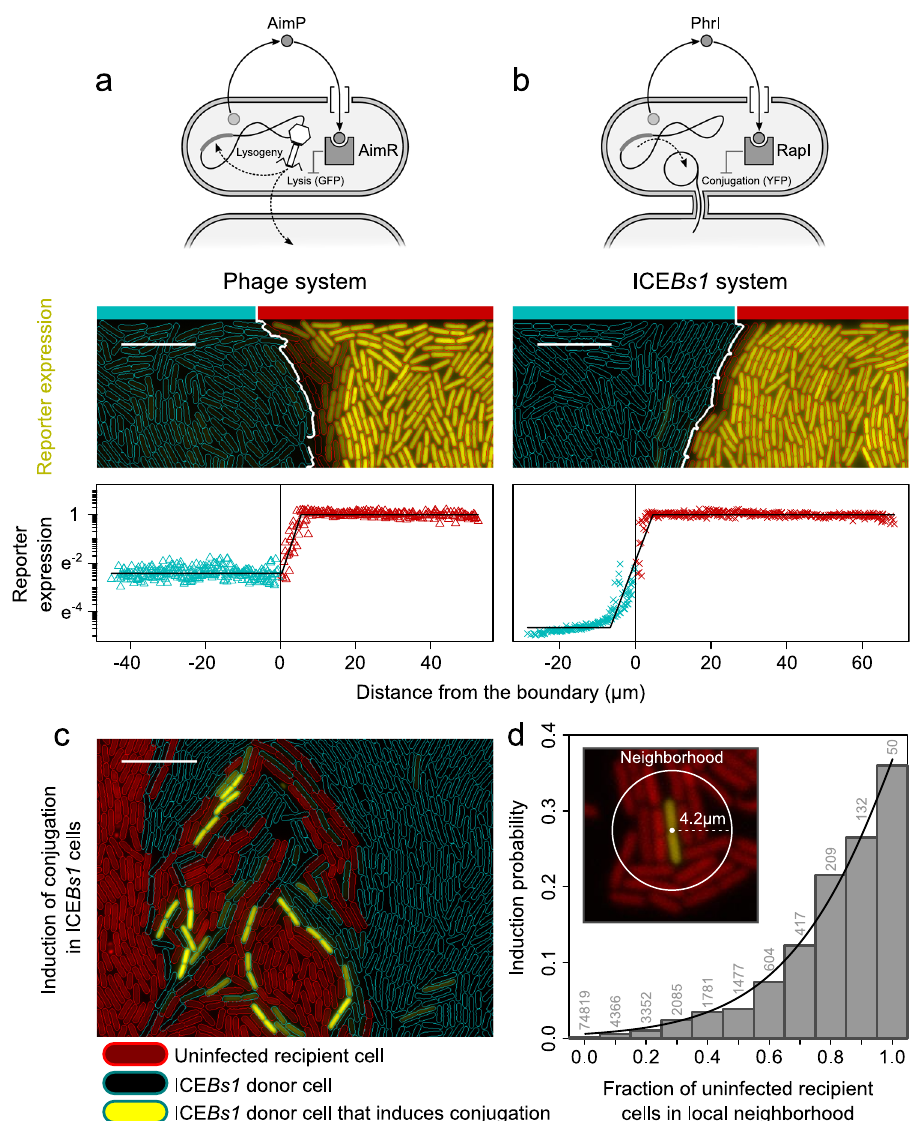
Fig. 4 Short-range communication regulates horizontal gene transfer. Quorum-sensing systems of a phage system ( φ 3T) and b integrative conjugative element (ICE Bs1 ). From top to bottom: scheme of quorum-sensing system, distribution of signal producers (blue outlines) and receivers (red outlines) and their reporter expression, GFP expression for φ 3T system (arti fi cially colored yellow), and YFP expression for ICEBs1 system (scale bar = 10 μ m), and reporter expression as a function of the distance of cells to the boundary of signal producers. Reporter gene expression indicates induction of horizontal gene transfer: lytic lifestyle for phage system and conjugation for ICE Bs1 element. Black line marks best- fi t curves (see “ Methods ” ). The zone of inhibition is determined by the spatial distance from the boundary of signal producers, where we observe repression in reporter gene expression (Supplementary Fig. 19). c Representative microscopy image of coculture of Δ conB ICE Bs1 donor cells (blue outline) and uninfected recipient cells (red outline) (scale bar = 10 μ m). Donor cells that express YFP induce conjugation. d Induction probability as a function of fraction of uninfected recipient cells in the local neighborhood ( n ¼ 89 ; 292 cells; numbers above bars in plot show how cells are distributed across neighborhoods). Neighborhood size is determined by the zone of inhibition. Induction probability increases signi fi cantly with fraction of uninfected recipient cells in the local neighborhood (regression: y